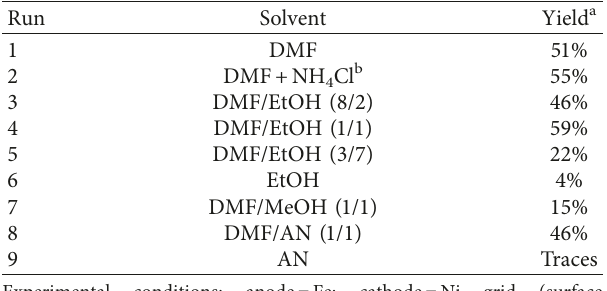
AN Traces Experimental conditions: anode � Fe; cathode � Ni grid (surface area � 30cm 2 ); current intensity I � 0.1A; supporting electrolytes: TBABr